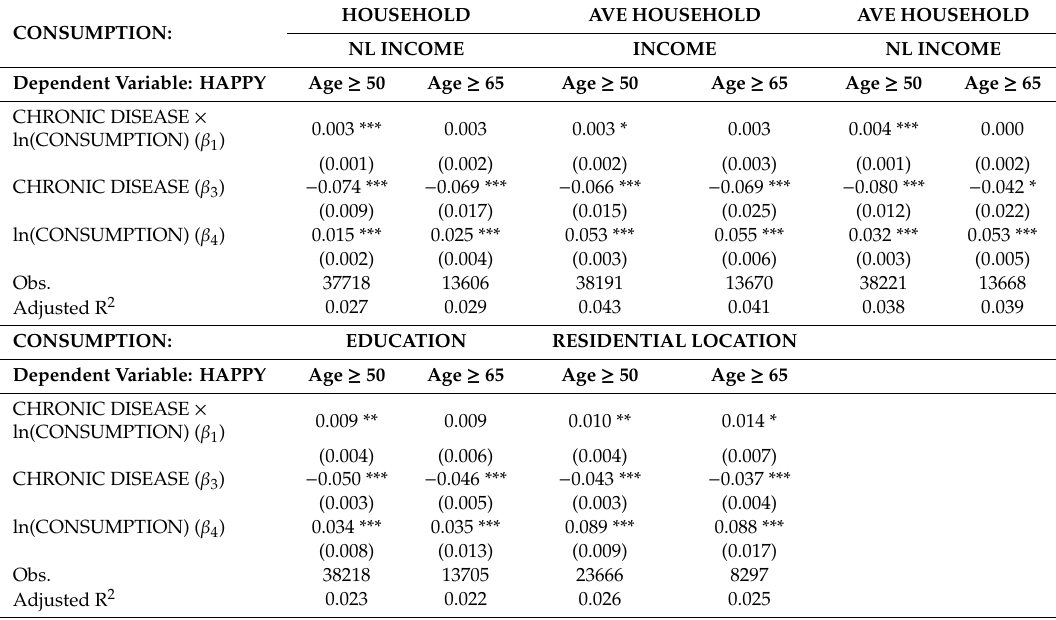
Table 11. Consumption proxies.